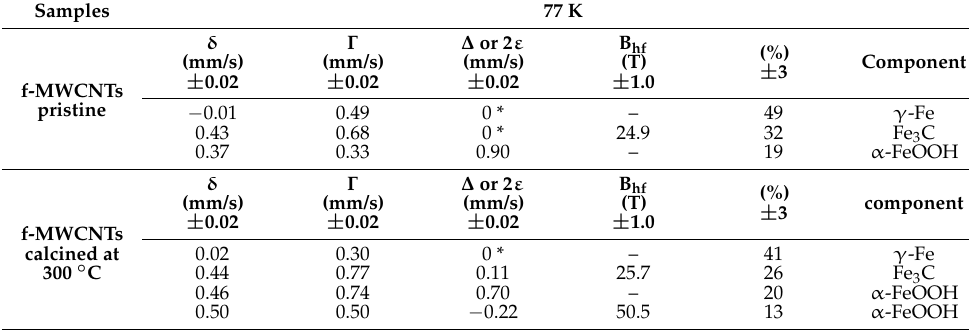
Figure 13. Mössbauer spectra measured at 77 K for f-MWCNTs: ( a ) as-received; ( b ) calcined at 300 °C. Table 3. Refined values of hyperfine Mössbauer parameters in pristine and calcined f-MWCNTs determined at 77 K: δ : isomer shift; Γ : full width at half height; ∆ : quadrupolar splitting; 2 ε : quadrupolar shift; B hf : hyperfine